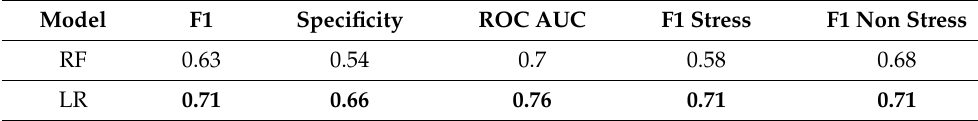
Table 4. Classification scores from MMSD dataset using RF and LR models.